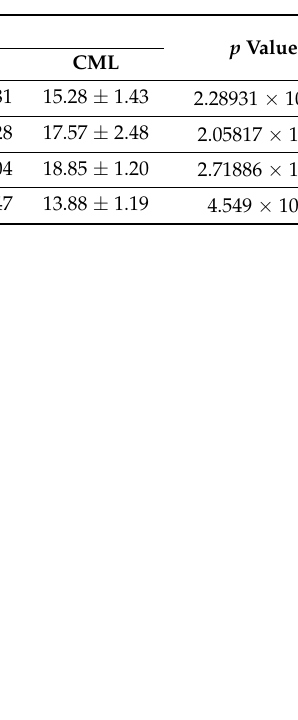
Table 3. Color changes in the dental composites’ using VITA EasyShade.